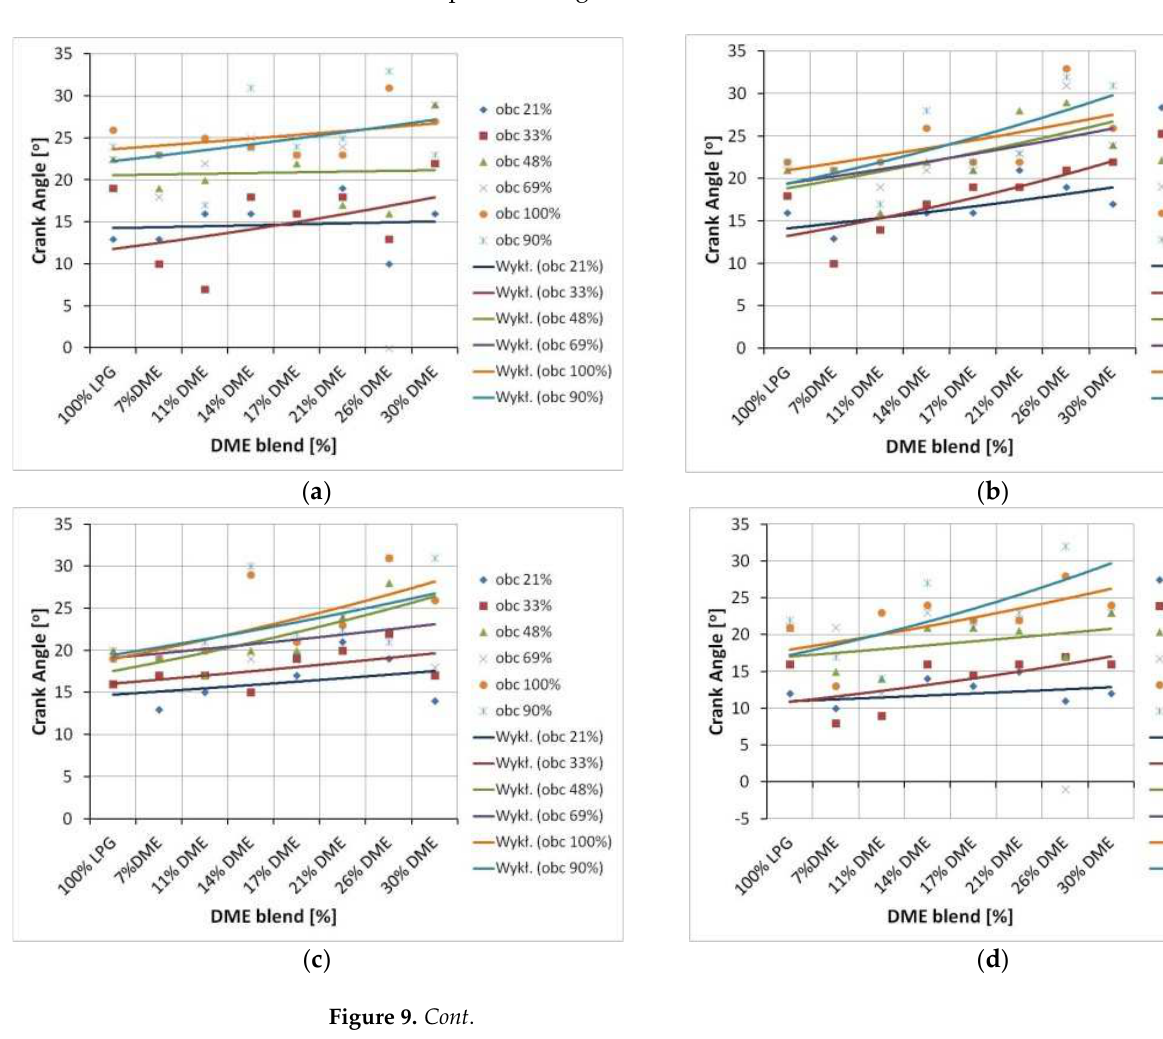
Figure 8. Maximum in-cylinder pressure value vs. crank angle (33% load and 3,000 RPM, presented as the sum of the consecutive data series).